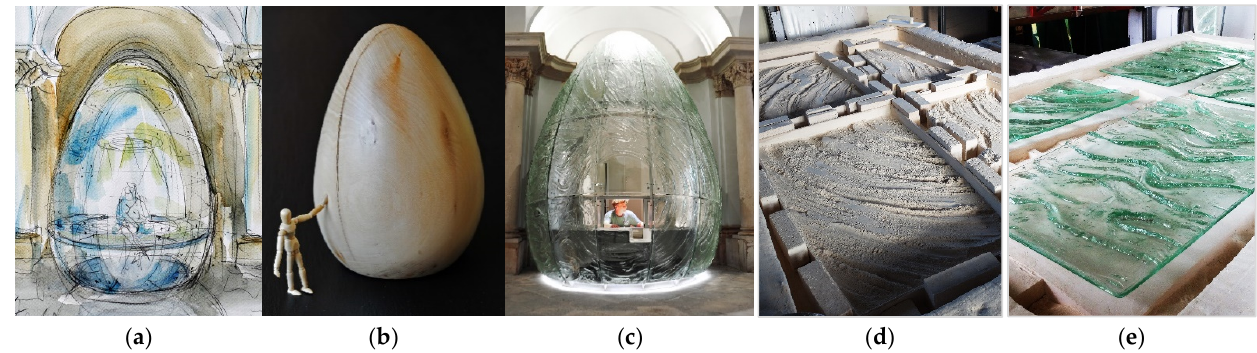
Figure 3. Glass art EGG by Tomasz Urbanowicz and Konrad Urbanowicz in the main building of the University of Wrocław, Poland, 2019: ( a ) watercolor project; ( b ) wooden scale model 1:15 (Tomasz Urbanowicz); ( c ) completed commission; ( d ) forms in the kiln before glass casting; ( e ) relief glass structure before glass bending (Konrad Urbanowicz).